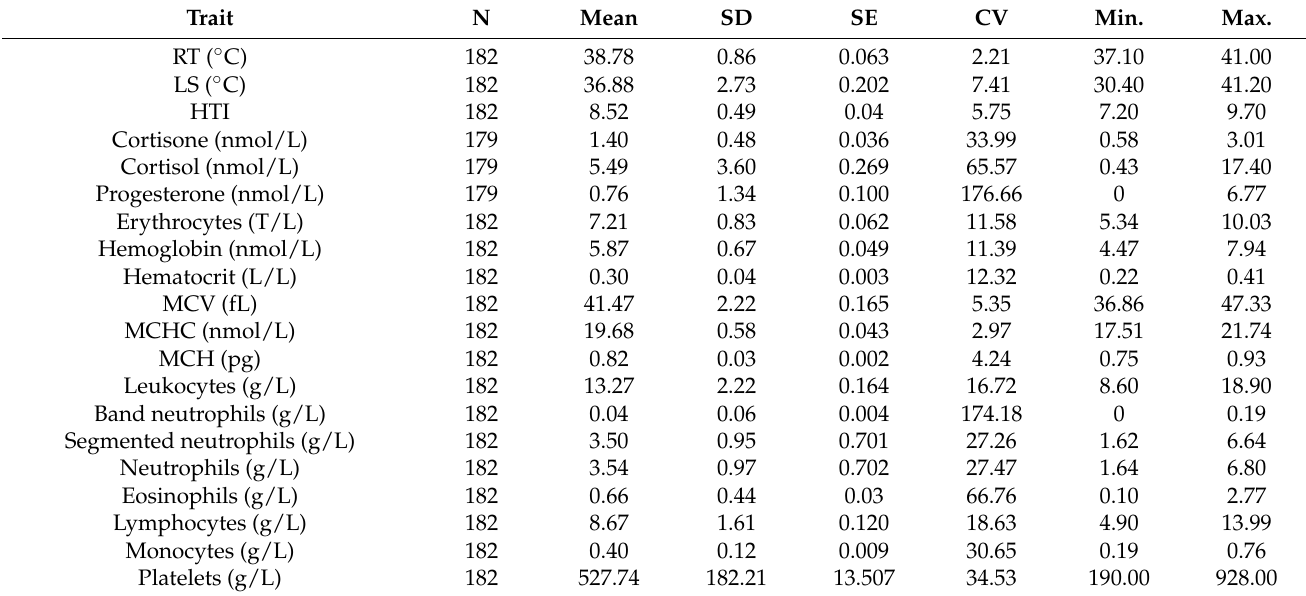
Table 4. Descriptive statistics (N: number of observations, mean, SD: standard deviation, SE: standard error, CV: coefficient of variation, minimum and maximum) of the physiological, hormonal and hematological traits